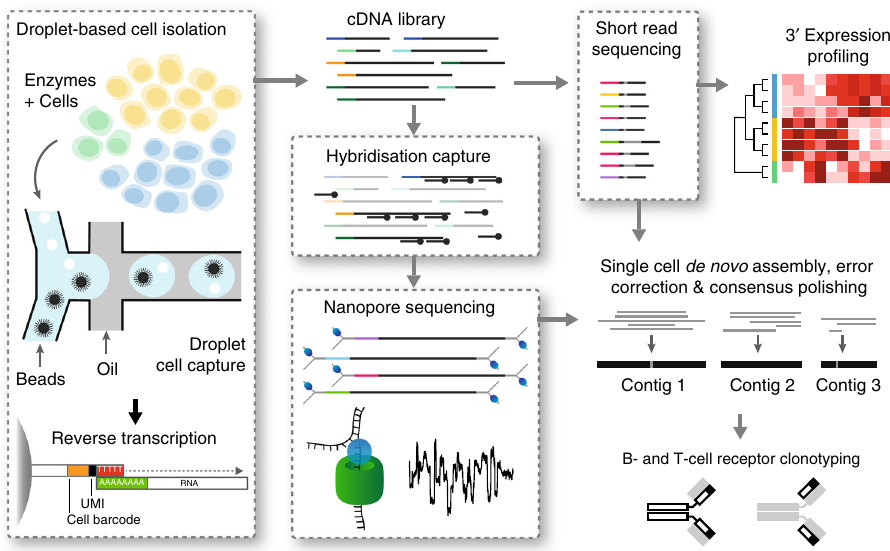
Fig. 1 Overview of RAGE-Seq. Droplet-based scRNA-Seq is used to generate an initial barcoded cDNA library, which is split and simultaneously subjected to (i) short-read sequencing for 3 ’ expression pro fi ling and (ii) targeted capture using custom probes followed by long-read sequencing. The short-read sequencing is used to generate highly accurate cell-barcode sequences which permit demultiplexing of the long-read data. Demultiplexed long-reads are subjected to de novo assembly and error correction to generate full-length BCR and TCR mRNA sequences, with single nucleotide accuracy. Transcriptome pro fi les generated from short-read sequencing can then be linked to the antigen – receptor sequence for each individual